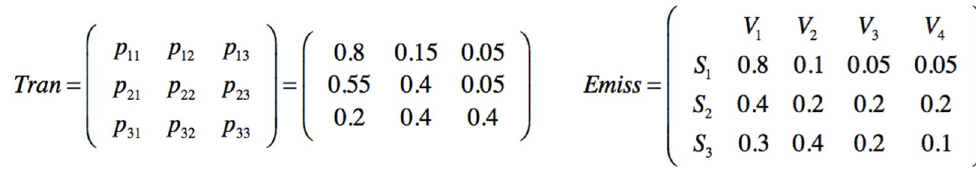
Figure 26. Prior transition and emission matrices for mitigative safety barriers and end states.